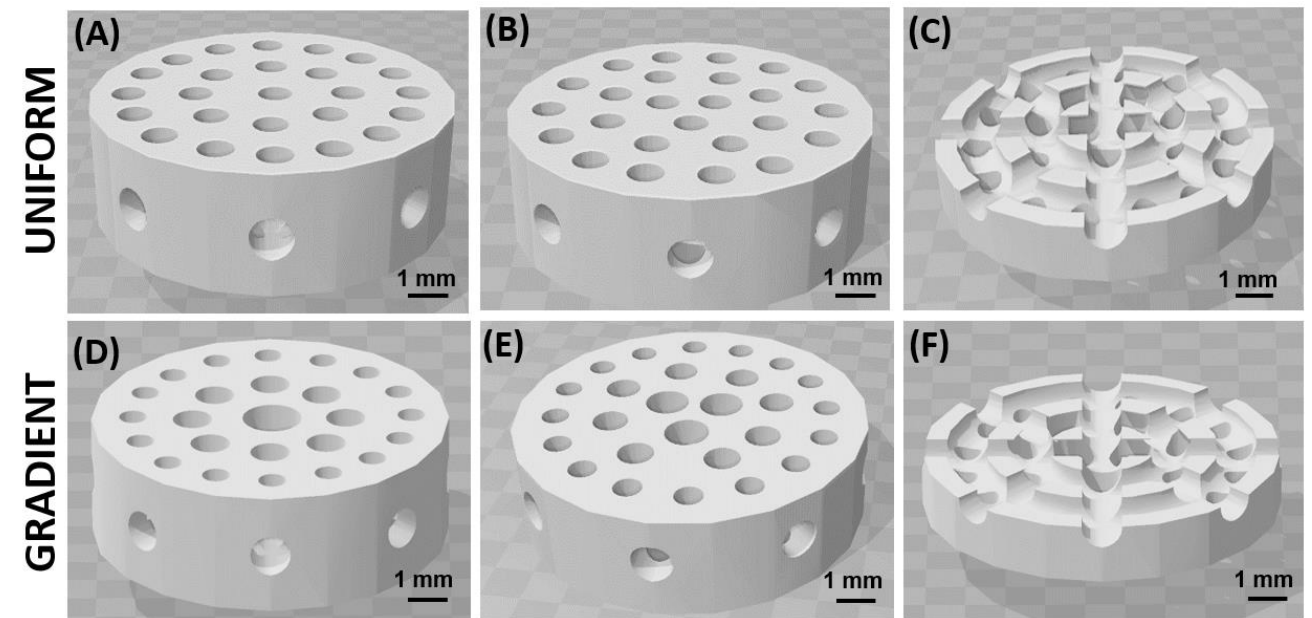
Figure 1. Images of the CAD models (.stl files) of the two geometries: scaffolds with pores with uniform size and pores with a size gradient. Views from both sides ( A – E ) and views of the cross- sections ( C , F ). In the cross sections: circular channels and radial channels connect the vertical pores.